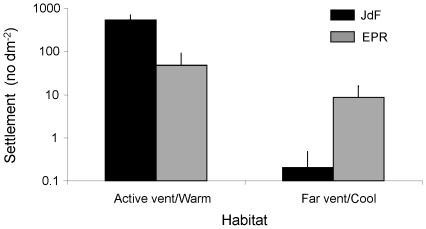
Patterns in settlement of gastropods (+SD) at vents.These measures were taken using colonization plates placed within 0.5 m of the orifice of an active vent (Juan de Fuca Ridge, [10]) or at warm vents (East Pacific Rise, [9]) and at ∼10 m from an active vent (Juan de Fuca Ridge, [10]) or at cool vents (East Pacific Rise, [9]). Source of variation is within each study.